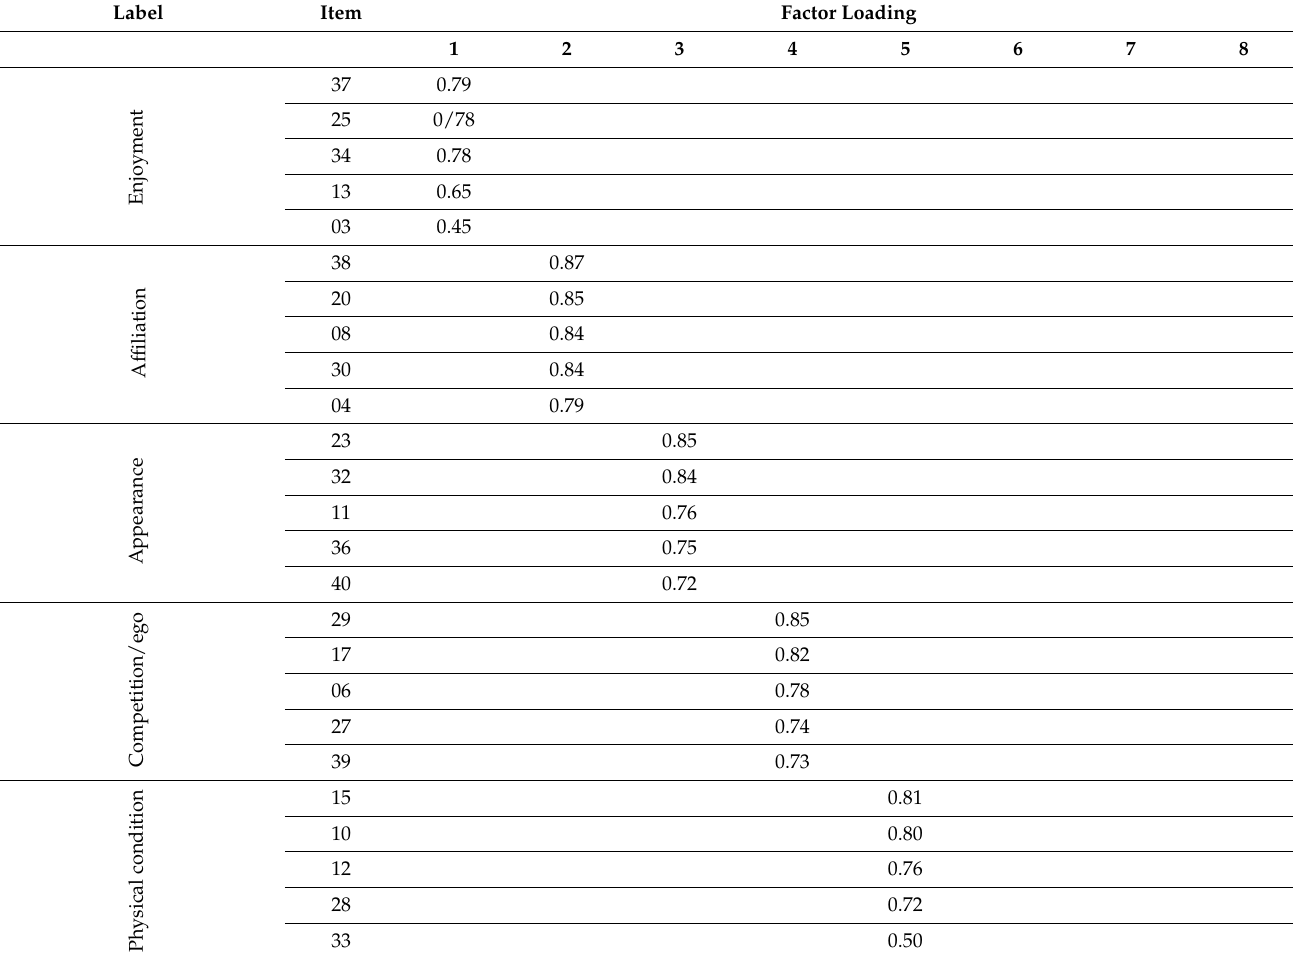
Table 3. Summary of Exploratory Factor Analysis of the PALMS-D using varimax